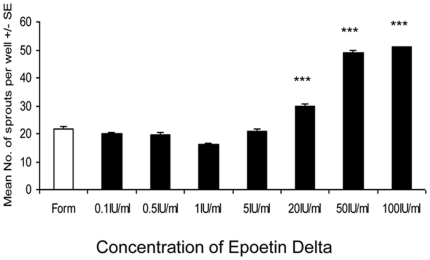
The effect of Epoetin delta on angiogenesis in vitro.The effect of epoetin delta was determined using the in vitro angiogenesis model in primary HDMEC cells. At doses >20 IU/ml there is a significant increase in angiogenesis (n = 6). Doses <20 IU/ml is not angiogenic. (Error bars  =  Standard Error of the Mean ***p<0.001.